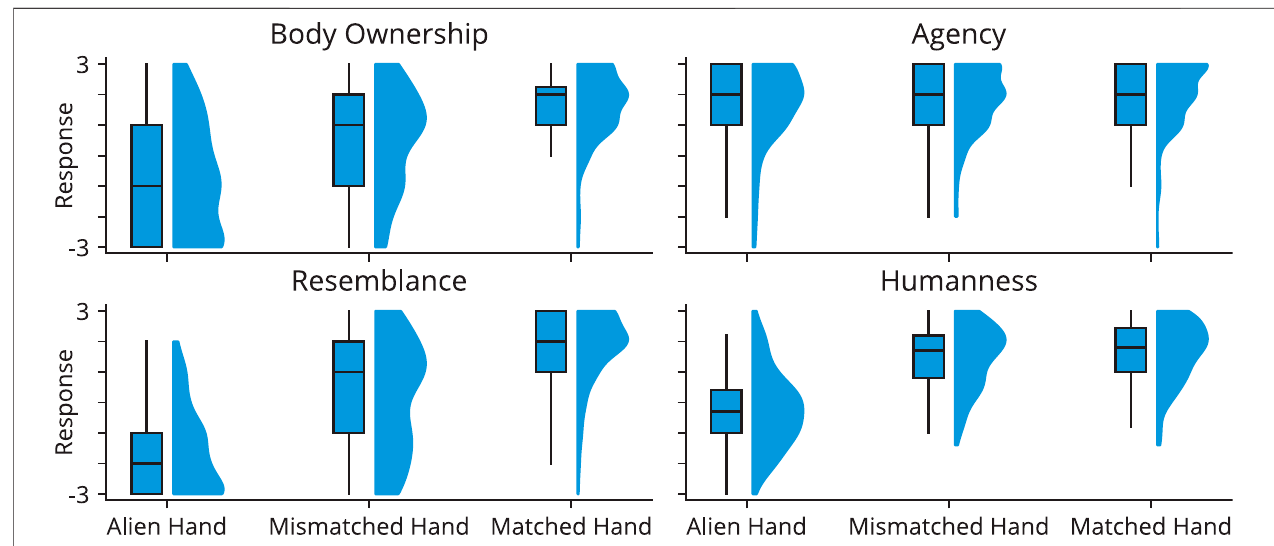
Frontiers in Virtual Reality |